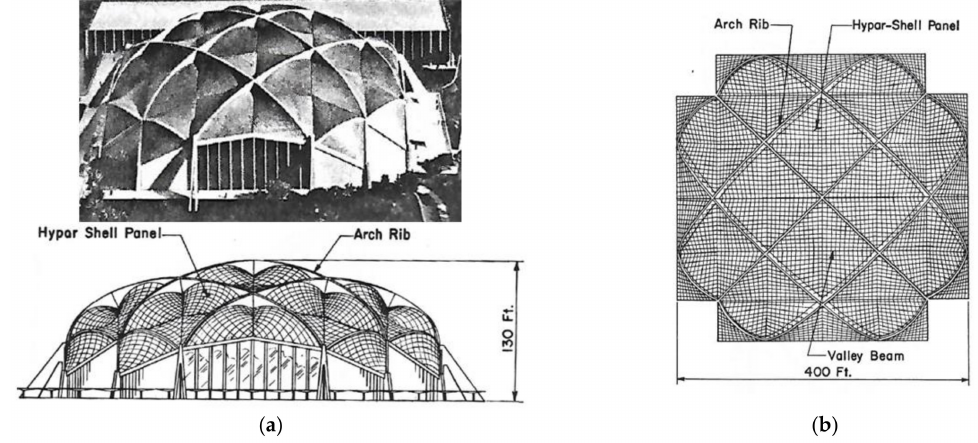
Figure 9. The Field House structure invented by Biswas and Iffland: ( a ) concept and elevation; ( b )